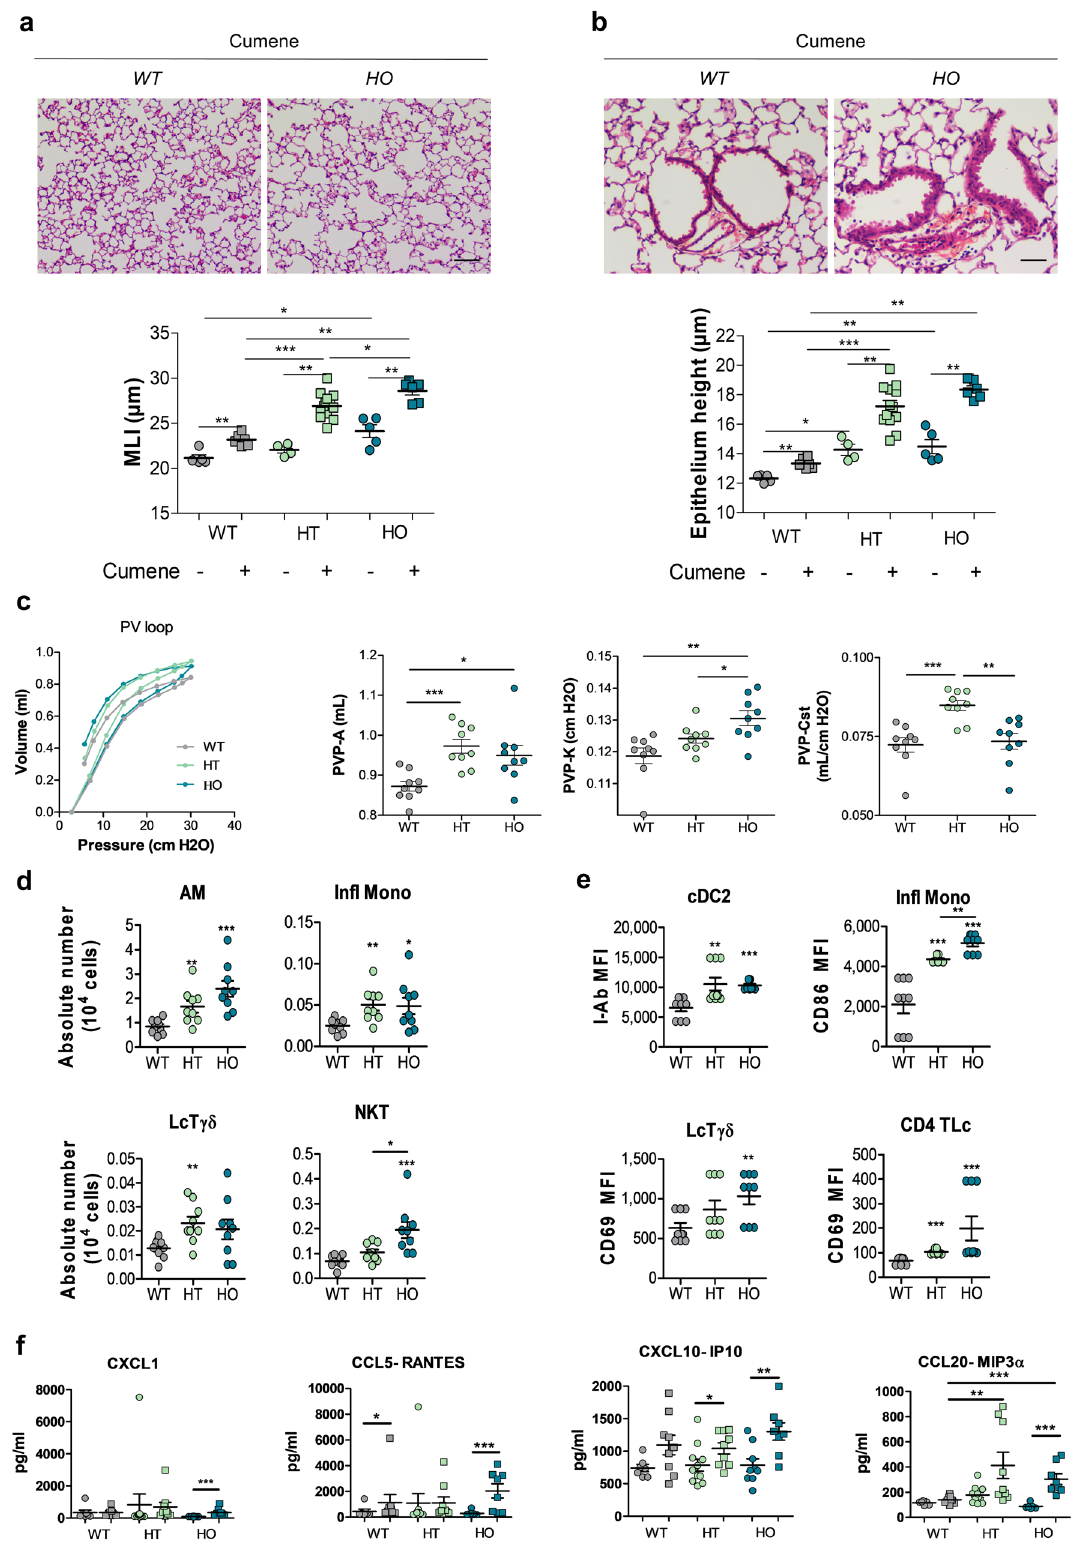
TNF- α 54 , largely prevented pathological remodeling of tracheal epithelium in α 5SNP mice (Fig. 4c), and NF- κ B activation (Fig. 4e), con fi rming an important role of TNF- α in α 5SNP- induced epithelial